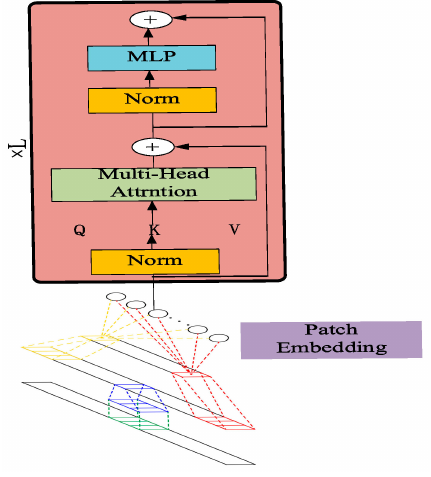
Figure 2. Encoder composition structure